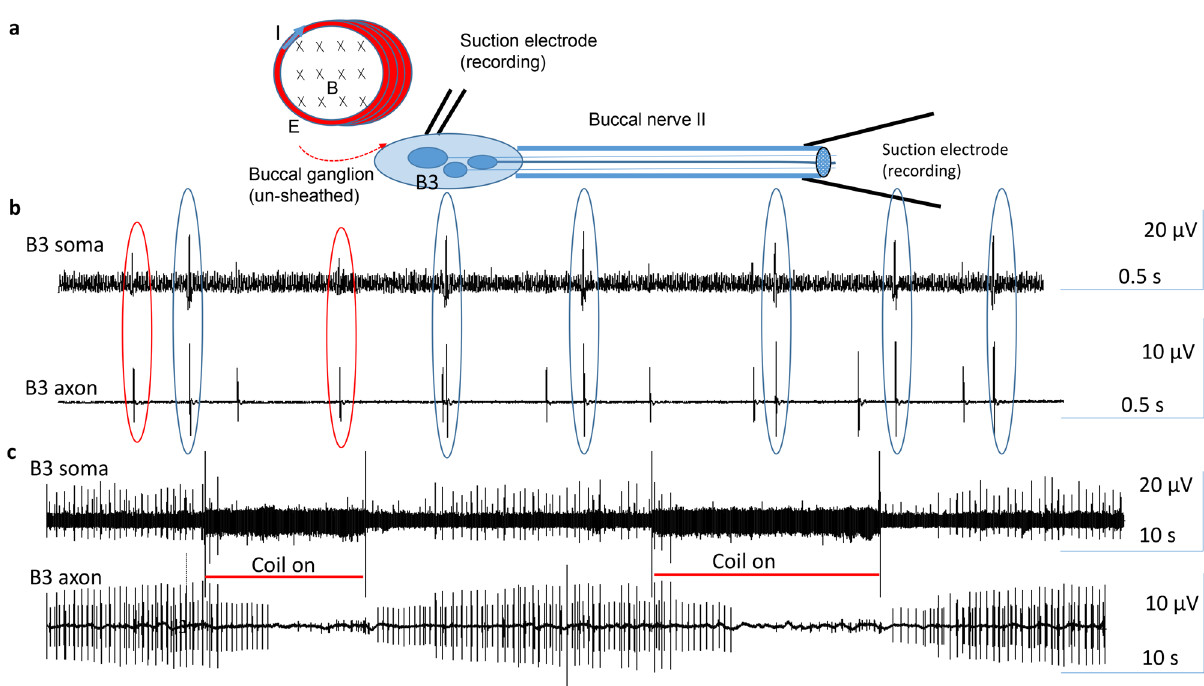
Figure 7. Trans-sheath inhibition of the soma activity by the magnetic stimulation. ( a ) Experimental setup and orientation of the coil to the buccal ganglion. An extracellular electrode was positioned ganglion sheath, right above the soma of the B3 neuron in the un-disheathed buccal ganglion. Another suction electrode was applied to the distal end of the BN2. ( b ) One-to-one relationship between the soma and axon activities were observed in two neurons (blue and red circles). ( c ) Magnetic stimulation on the buccal ganglion eliminated the action potentials in both the soma and axon in both